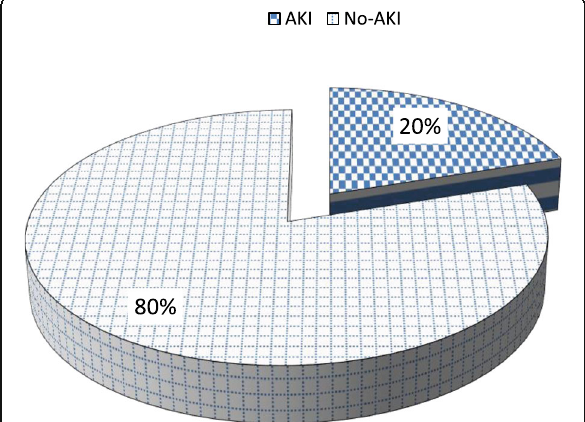
Fig. 1 Frequency of AKI in the current